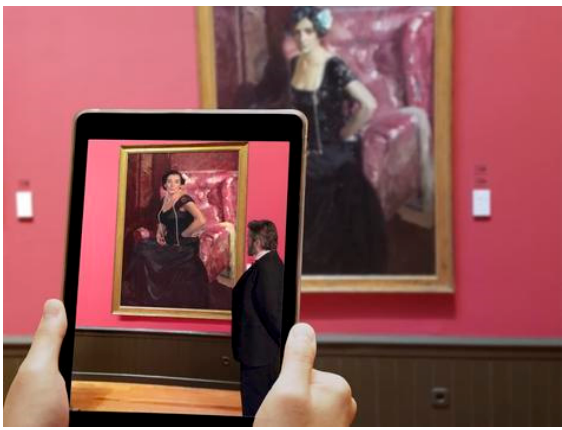
Figure 2. The Sorolla Museum’s use of AR. Source: Google Play.